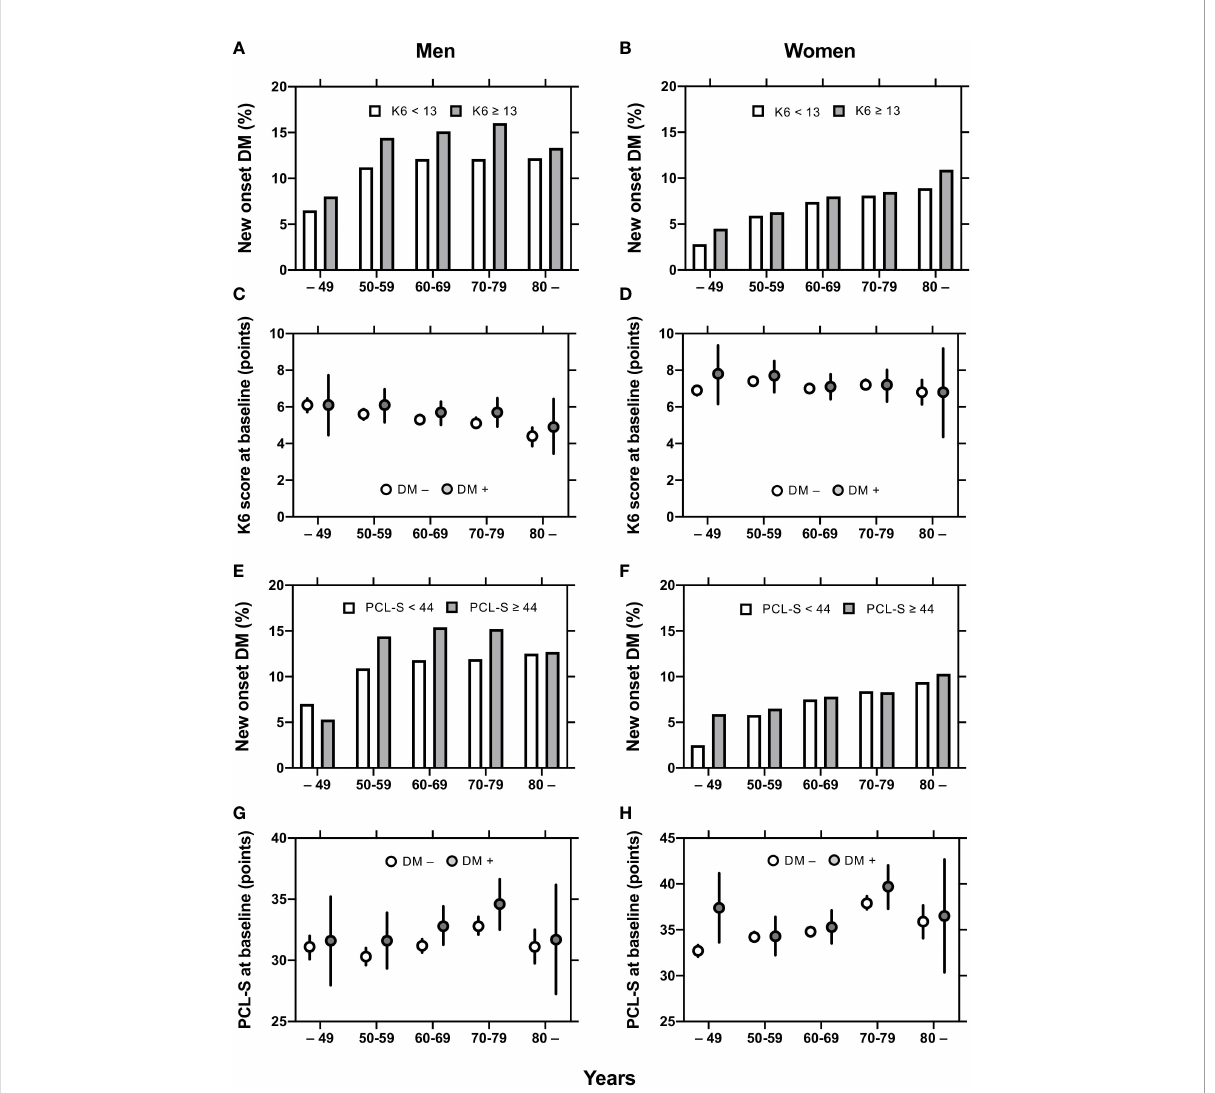
FIGURE 2 Mean K6 and PCL-S and incidence of new-onset diabetes in men and women. Diabetes incidence by age groups are shown in K6 < 13 (open columns) and K6 ≥ 13 (closed columns) participants (A, B) and in PCL-S < 44 (open columns) and PCL-S < 44 (closed columns) participants (E, F) . Mean values ± 95% con fi dence intervals [95% CI] of K6 (C, D) and PCL-S (G, H) by age groups are shown in participant with (closed circles) or without (open circles) new-onset diabetes mellitus. K6: Kessler 6, PCL-S: PTSD Checklist Stressor-Speci fi c Version; DM: diabetes